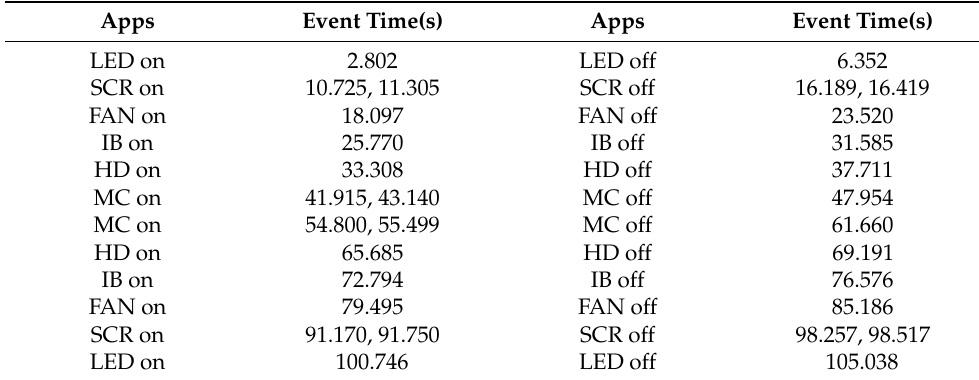
Table 3. The events time of appliances (Apps).